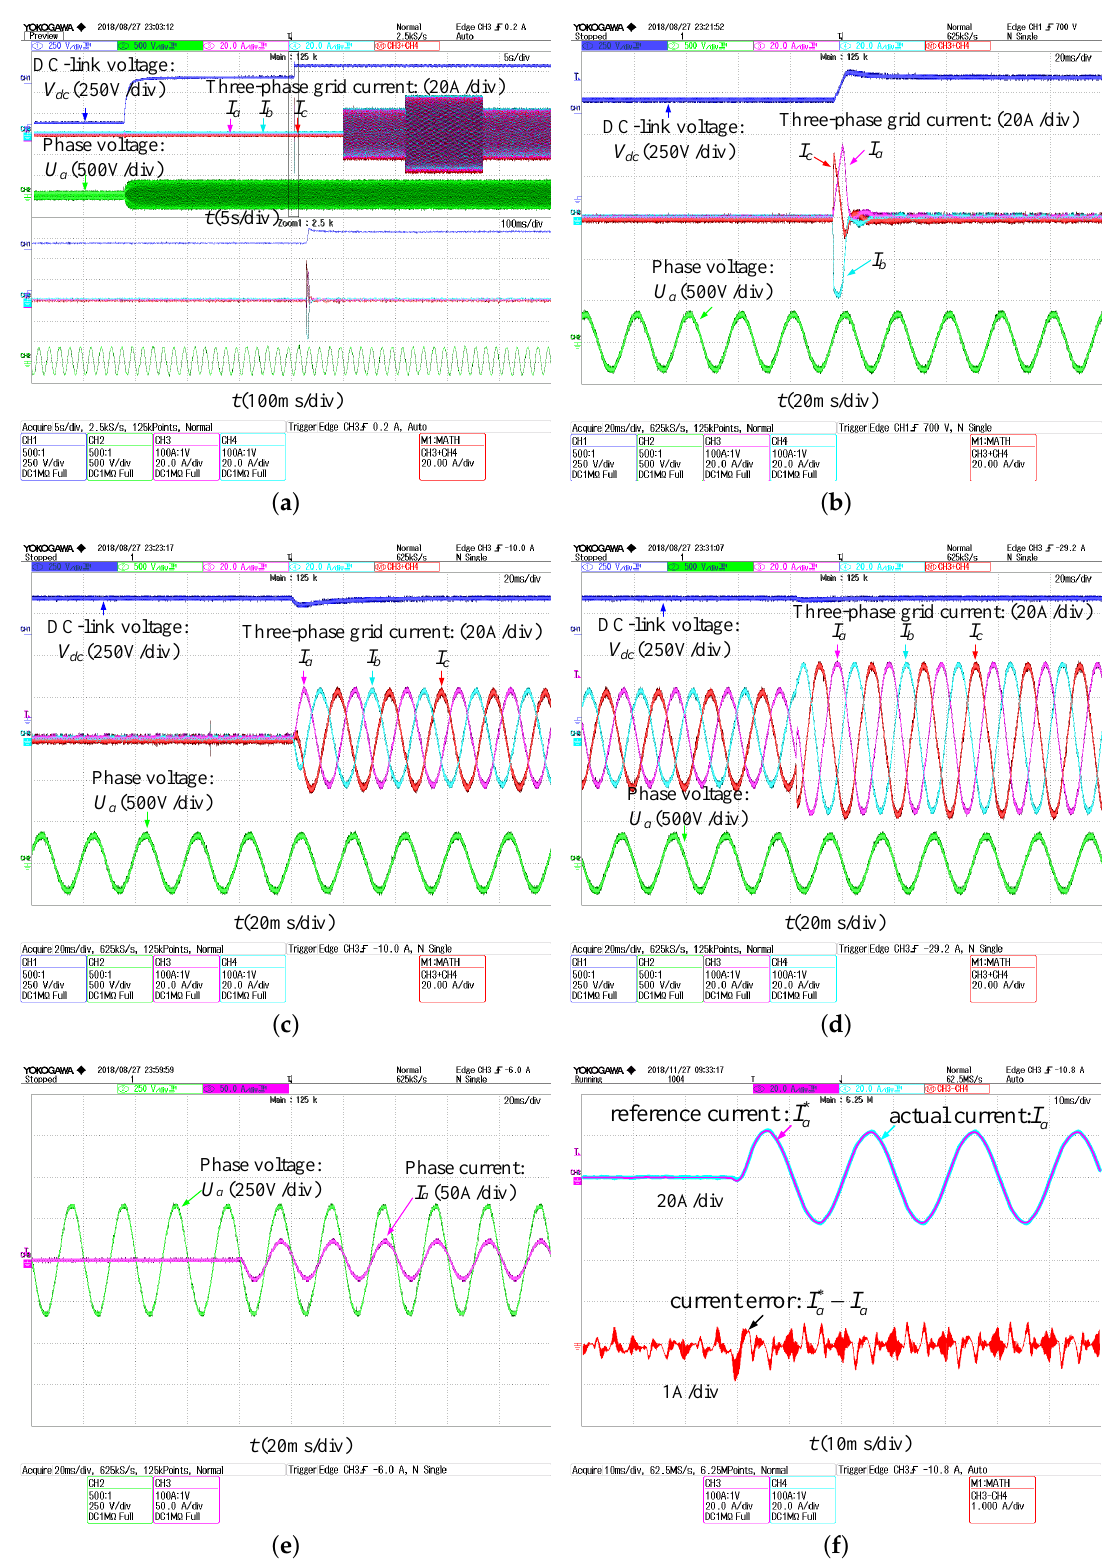
Figure 16. Experimental results of the proposed control strategy: ( a ) general view of the DC-link capacitor voltage and three-phase grid current; ( b ) three-phase grid current when the GC-VSC operates in the state of PWM rectifier; ( c ) three-phase grid current when 10 kW active power is applied; ( d ) three-phase grid current when 10 kvar reactive power is added; ( e ) grid voltage and current of phase A when unity power control is implemented; and ( f ) reference current, actual current and current error of phase A when load